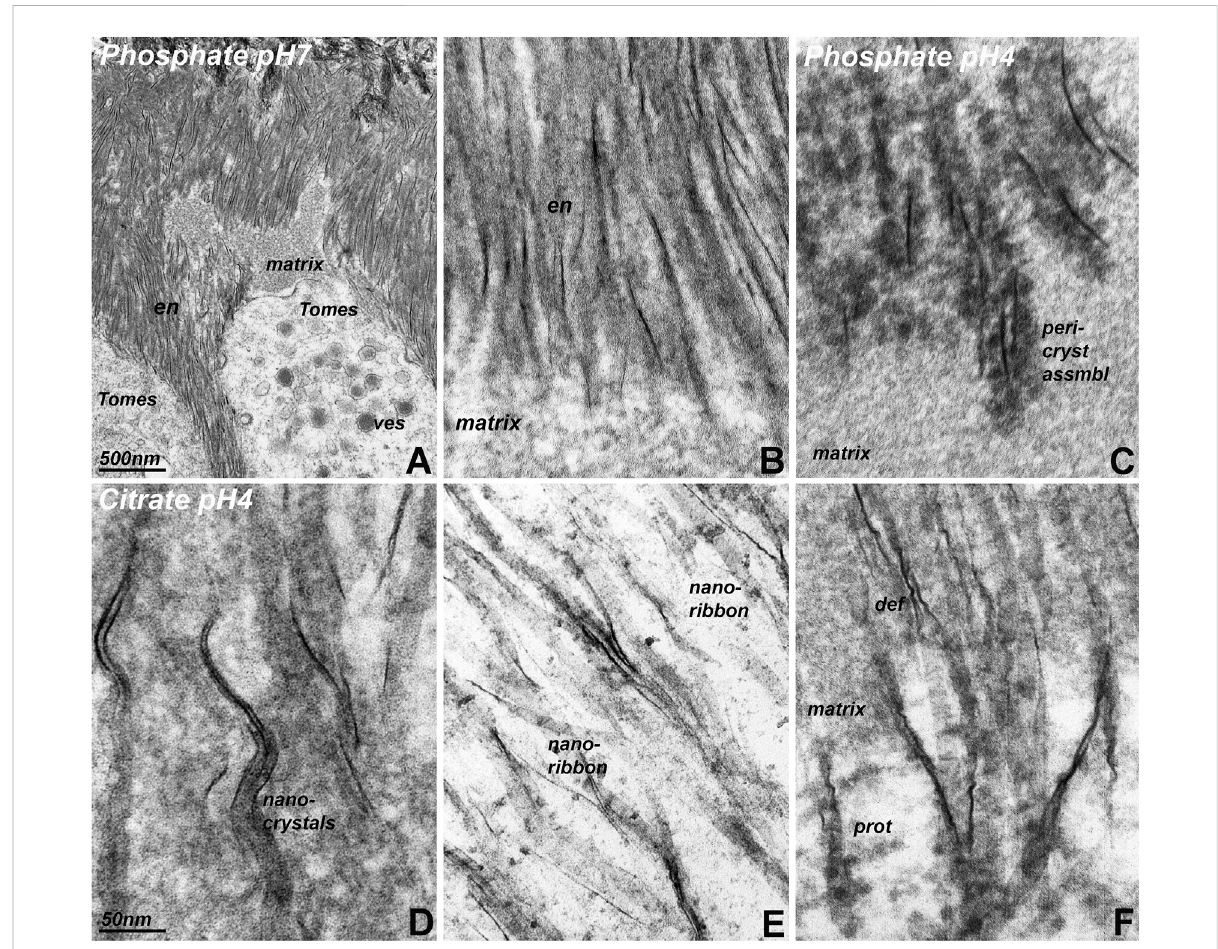
FIGURE 5 Transmission electron micrographs of initial enamel crystals embedded in enamel matrix after immersion in phosphate and citrate buffers at pH4 andpH 7. (A) Overviewelectronmicrographillustrating theposition ofTomes ’ process (Tomes) loaded with secretory vesicles (ves) adjacent to enamel matrix deposits (matrix) and newly formed enamel crystals (en). (B) is a high magni fi cation image of the initial enamel crystal (en)/matrix (matrix) interface of the same specimen. (A,B) were subjected to phosphate buffer at pH 7. (C) Initial enamel crystal/matrix interface in a specimen subjected to phosphate buffer at pH 4. Note the intensely contrasted peri-crystalline protein matrix (peri-cryst assembl) adjacent to the newlyformingenamelcrystals. (D – F) .Initialenamelcrystal/matrixinterfaceinaspecimensubjectedtocitratebufferatpH4.Theuseofcitratebuffer illustrates components of the initial enamel mineral phase, including nanocrystals (nanocrystals), ribbons (nanoribbon), and elongated enamel crystals).Proteinassemblies(prot, (F)